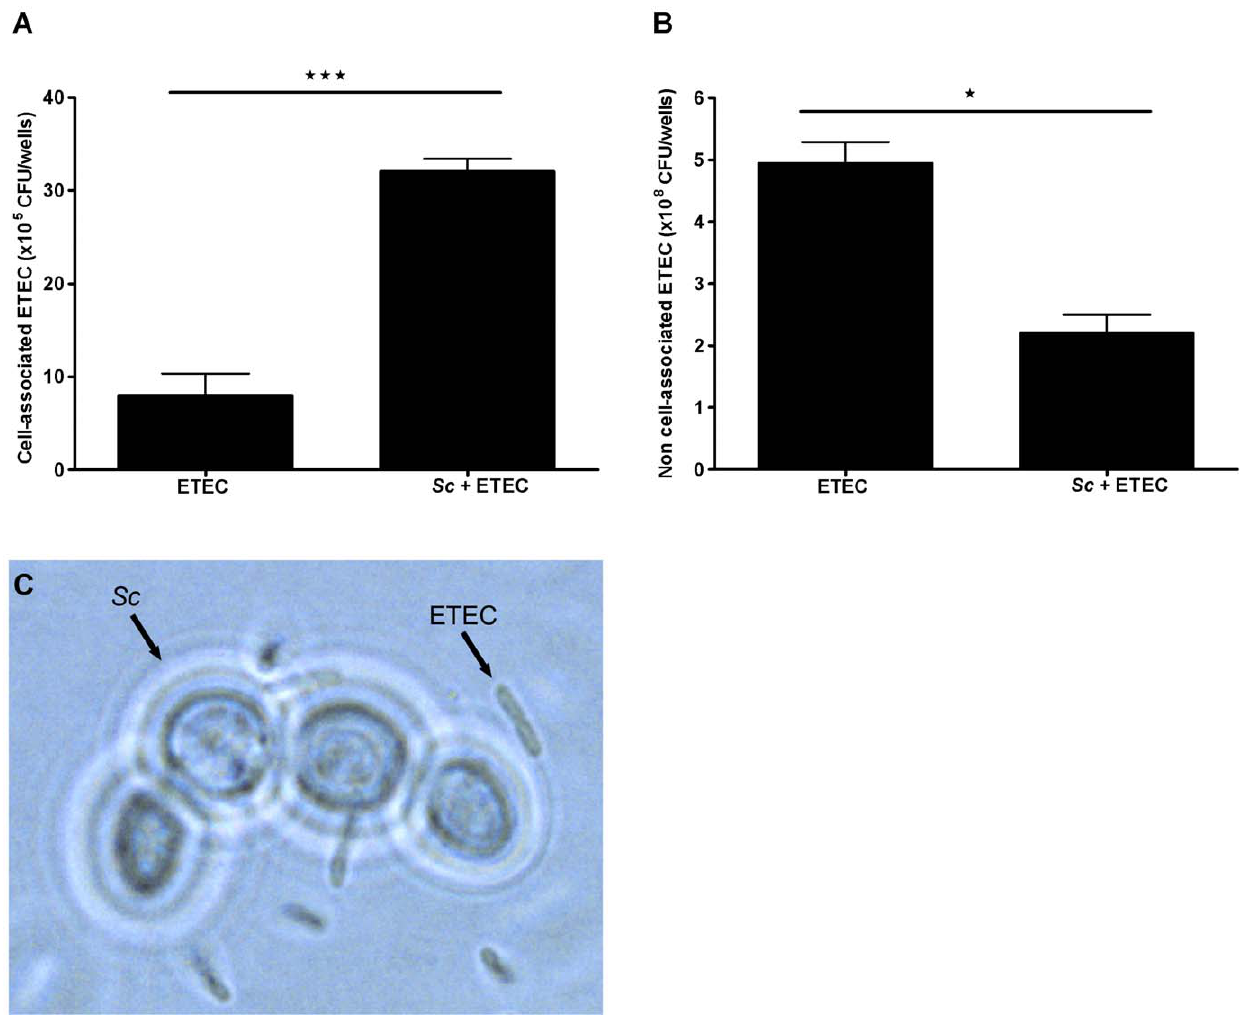
Figure 6. Saccharomycescerevisiae agglutinates ETEC. (A) IPEC-1 cells were exposed to ETEC (3 6 10 7 CFU/well) for 30 min in the presence or absence of Sc (3 6 10 6 yeasts/well). Cells were then lysed and cell lysates were diluted and plated on agar in order to quantify the cell-associated bacteria, ( n =4). (B) IPEC-1 cells were exposed to ETEC (3 6 10 7 CFU/well) for 3 h in the presence or absence of Sc (3 6 10 6 yeasts/well) and 100 m l of culture supernatant were then harvested from the apical compartment, diluted and plated on agar in order to quantify the non cell-associated bacteria, ( n =4). (C) IPEC-1 cells were overnight pre-incubated with Sc (3 6 10 6 yeasts/well) and then exposed to ETEC (3 6 10 7 CFU/well) for 3 h. Apical IPEC-1 cell culture supernatant was harvested and physical interaction between Sc and ETEC was observed by phase contrast microscopy (x 1000). Data are presented as means 6 SEM, asterisks denote: * ( P , 0.05 ), *** ( P , 0.001 ). (A, B) Data are representatives of two independent experiments.